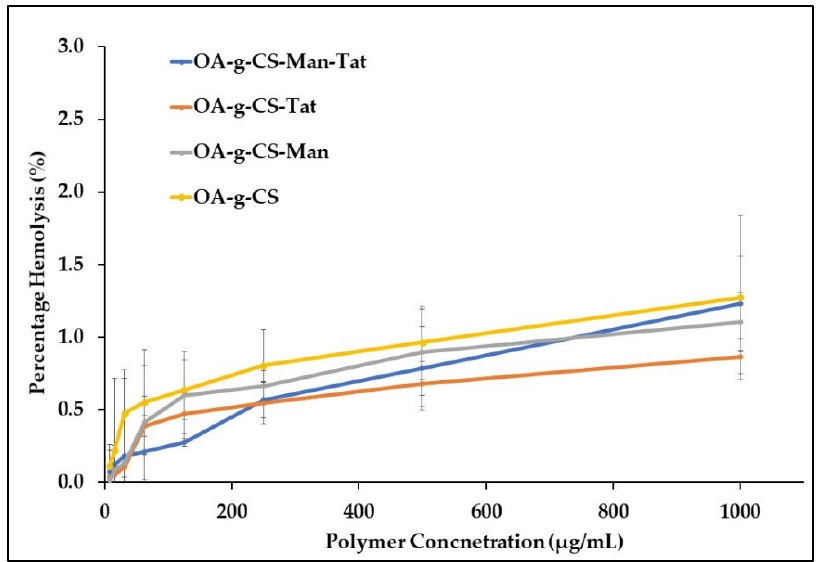
Figure 5. Hemolytic activity of chitosan-modified polymers at different concentrations. A total of 1% ( v / v ) Triton X-100 was used as a positive control (hemolytic activity was set as 100%) at 37 °C.